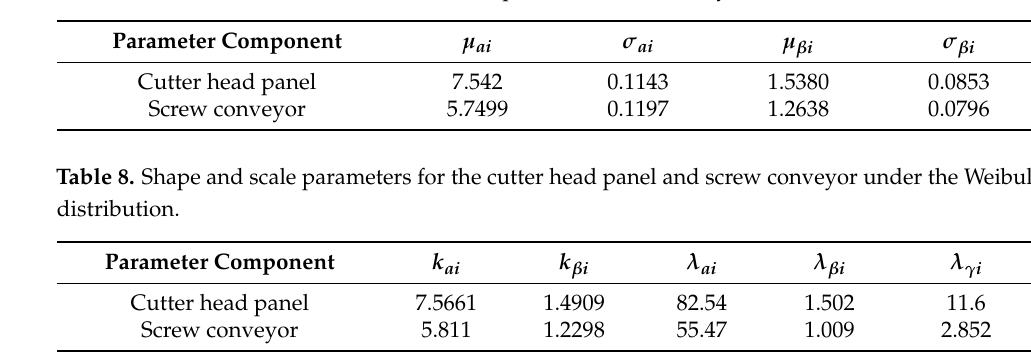
Table 7. Mean and variance for the cutter head panel and screw conveyor under the normal distribution.